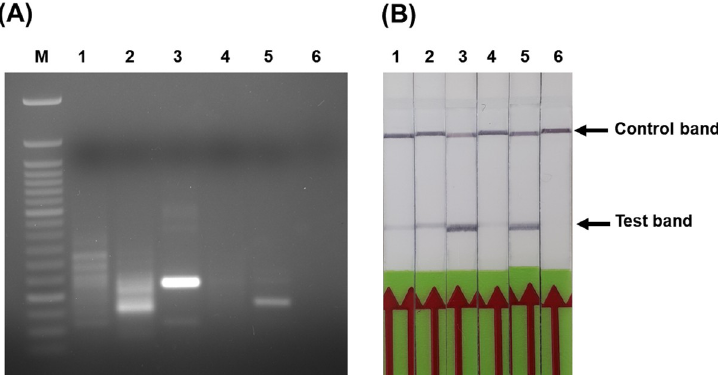
Fig 2. Screening of primers and nfo-probe for M . ovipneumoniae RPA assay. (A), RPA amplified products using four candidate forward primers with a single biotinylated reverse primer (BR) and a probe (LFP). Lane M, represents 50-base pair molecular weight ladder, 1; F1/BR/LFP, 2; F2/BR/LFP, 3; F3/BR/LFP, 4; F4/BR/LFP, 5; positive control (supplied by Twist Amp nfo kit), 6; negative control (DNase-free water). (B), RPA-LFD analysis of dual-labelled products generated using the designed primers and probe. Lane 1; F1/BR/LFP, 2; F2/BR/LFP, 3; F3/BR/LFP, 4; F4/BR/ LFP, 5; positive control (supplied by Twist Amp nfo kit), 6; negative control (DNase-free water).